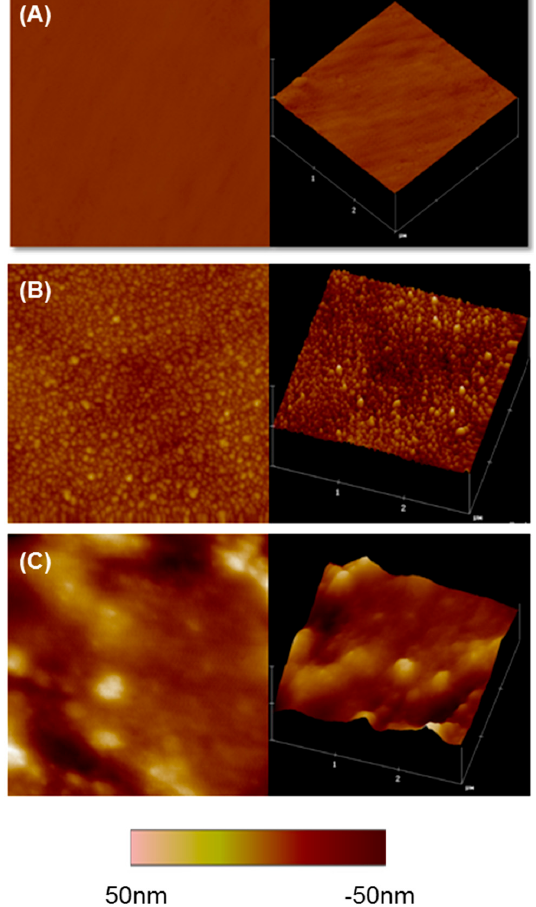
Figure 2. AFM images of non-coated and LbL-coated surfaces. ( A ) pTi non-coated surface; ( B ) One bi-layered Ti surface; and ( C ) ten bi-layered surface. Two-dimensional ( left ) and three-dimensional ( right ) representative images of the surfaces are shown. Scanned area shown is 3 × 3 µm.